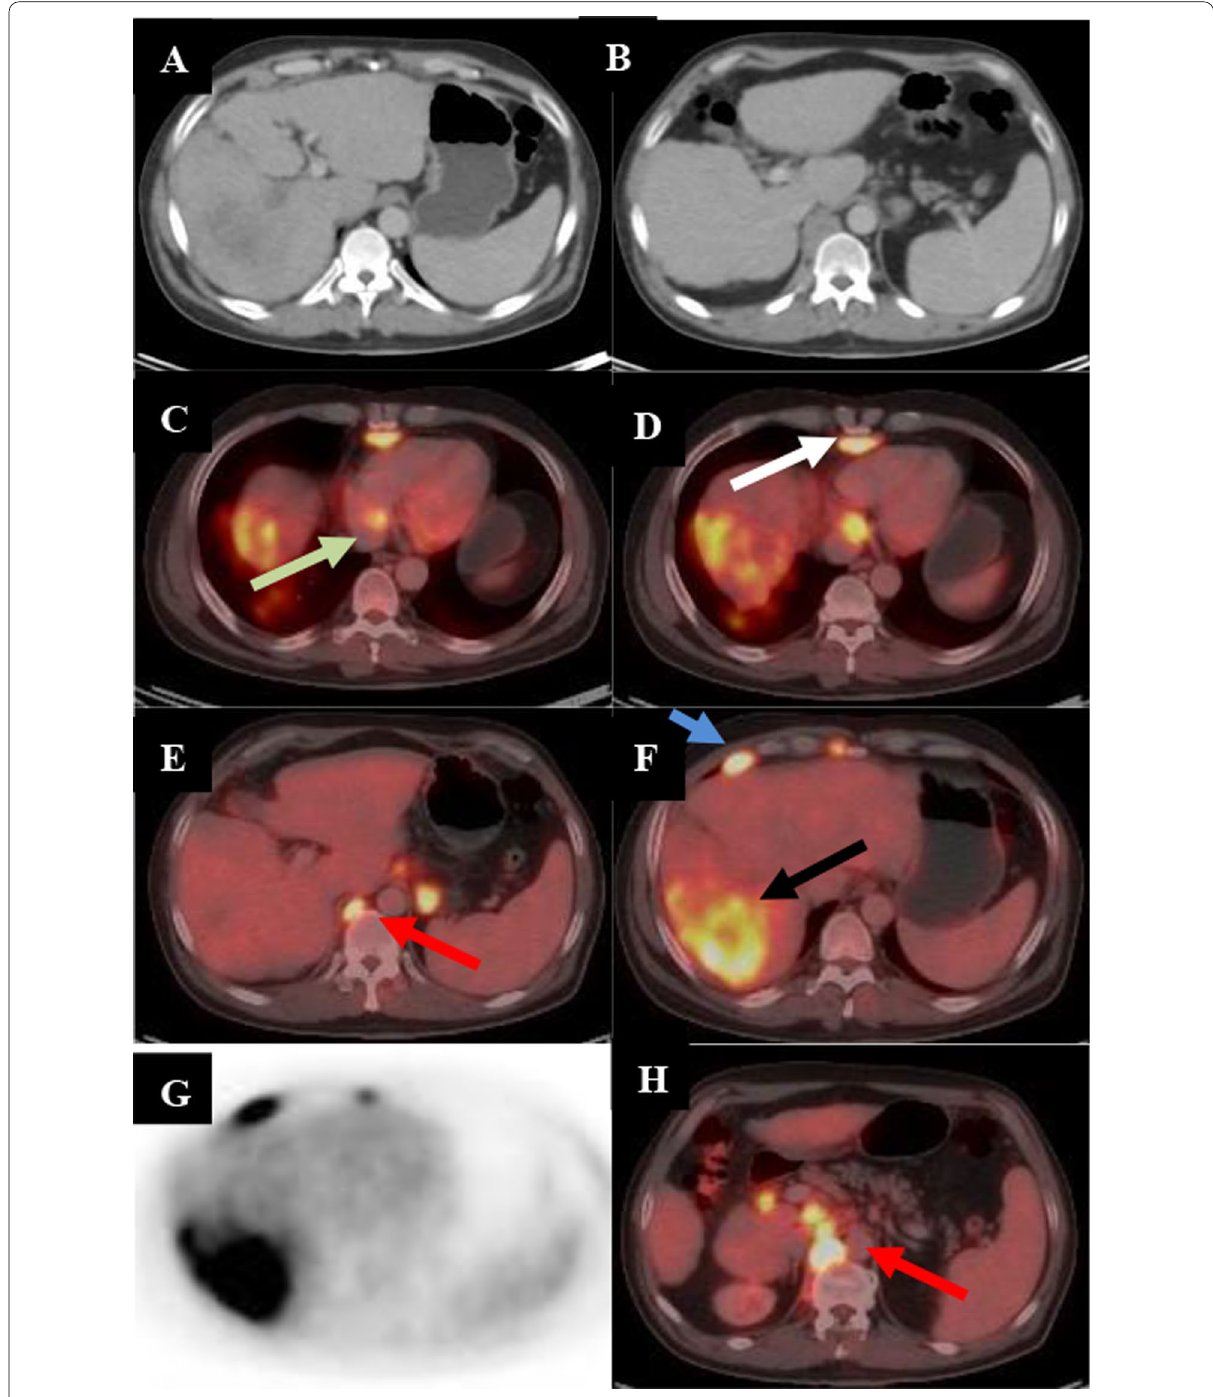
Fig. 3 A 54-year-old male patient, a known case of HCC, US was done showed HFL. A , B Triphasic CT showed HFL with radiological criteria of HCC, retroperitoneal deposit, and multiple suspicious LNs. C – I 18F FDG PET/CT showed furthermore metastases. PET/CT showing right lobe metabolically active lesion (black arrow) measuring 9 8 cm, with SUV max of 8.47, retrocrural LN (blue arrow) measuring 2 cm with SUV max of × 12.4. Retro peritoneal deposit (red arrow) measuring 1.5 cm with SUV max of 4.72. Right hilar LN measuring 7 mm with SUV max of 8.64. Inferior pericardial focal lesion (white arrow) measuring 1.5 cm with SUV max of 5.46., I coronal view showing metabolically active hepatic lesion with multiple